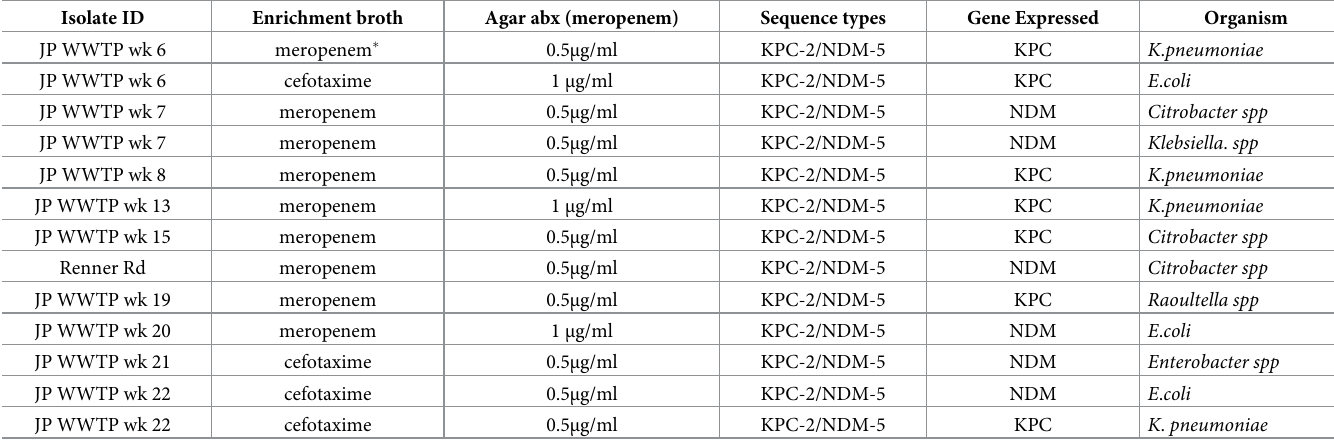
Table 5. Isolates harboring both resistance